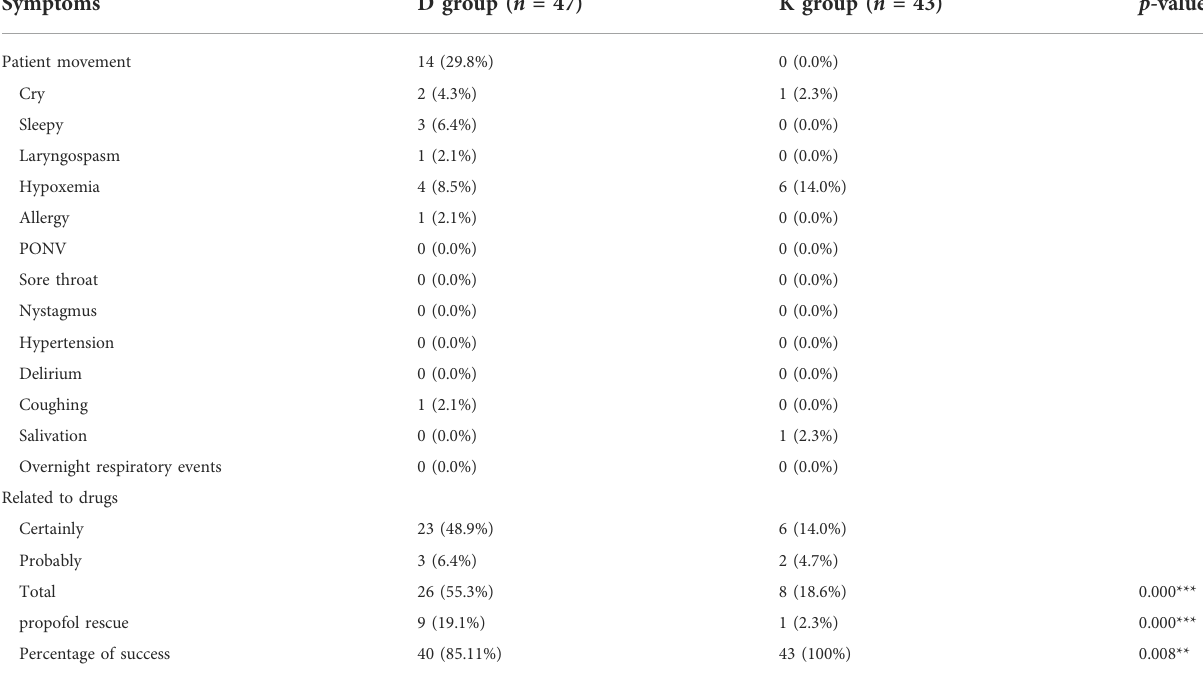
TABLE 4 Adverse effects, Propofol rescue and Percentage of